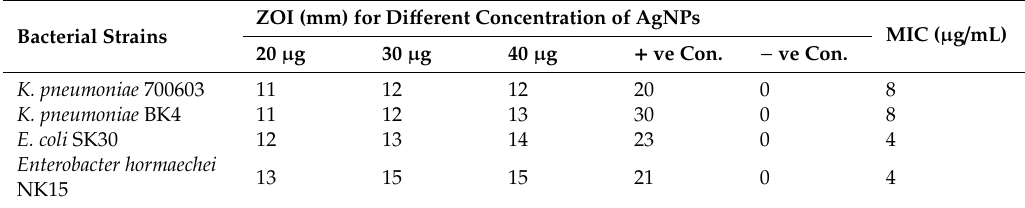
Figure 7. Antibacterial activity of biosynthesized AgNPs at different concentration against extended spectrum β -lactamase (ESBL) producing K. pneumoniae 700603, K. pneumoniae BK4, E. coli SK30, and Enterobacter hormaechei NK15 by well diffusion method. Table 1. Antibacterial activity of biosynthesized AgNPs against various ESBL producing Gram-negative bacteria by well diffusion method.